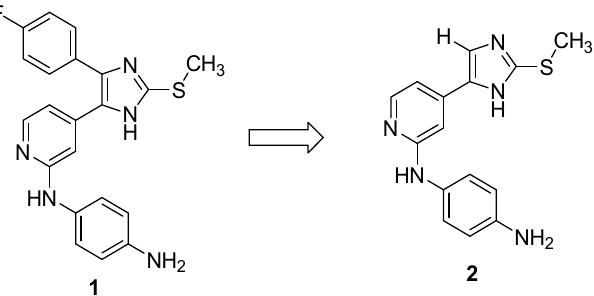
Figure 1. Structure of dual p38 α mitogen-activated protein (MAP) kinase/c-Jun N-terminal kinase 3 (JNK3) inhibitor 1 and design of the title compound 2 .